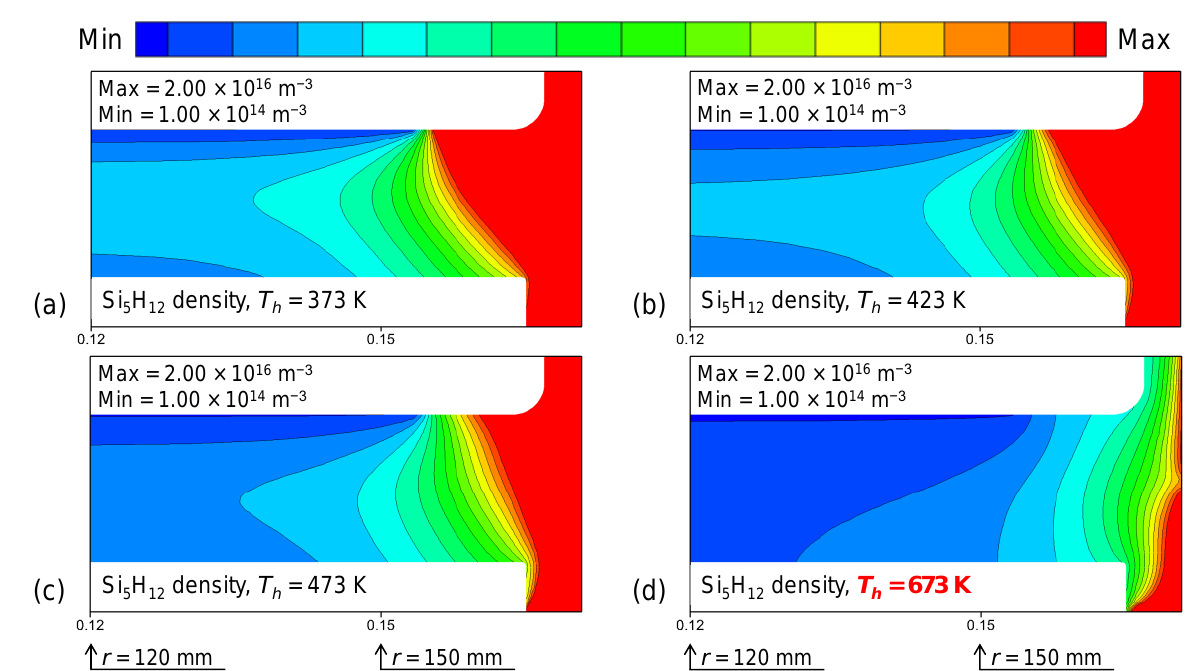
Figure 11. Effects of the showerhead temperature ( T sh ) on the spatial distribution of high-order silanes. Spatial variations in the Si 5 H 12 density distributions (m − 3 ) for ( a ) Case 2 ( T sh = 373 K), ( b ) Case 3 ( T sh = 423 K), ( c ) Case 4 ( T sh = 473 K), and ( d ) Case 5 ( T sh = 673 K).